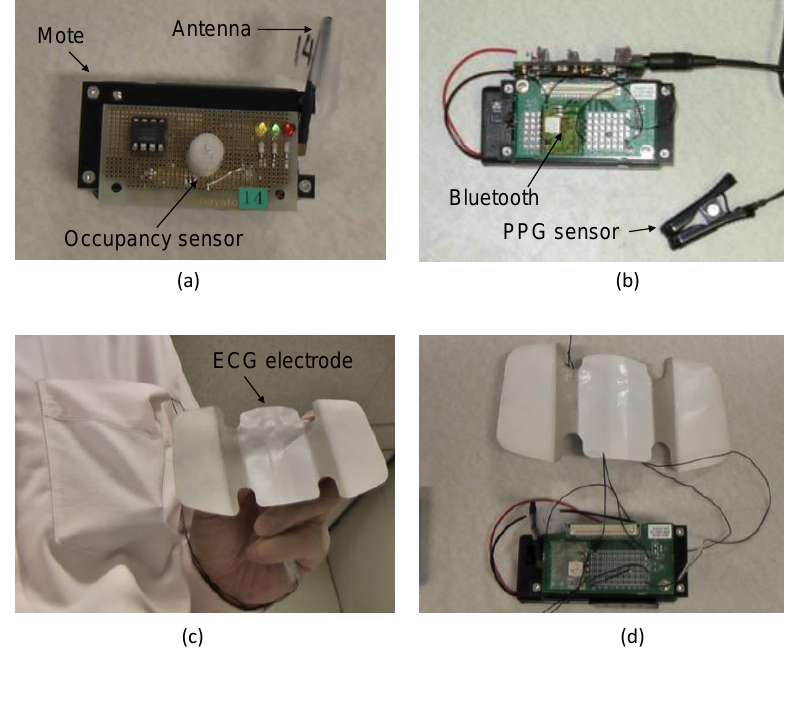
Figure 2. Sensor nodes. ( a ) Occupancy sensor; ( b ) PPG sensor; ( c ) and ( d ) ECG